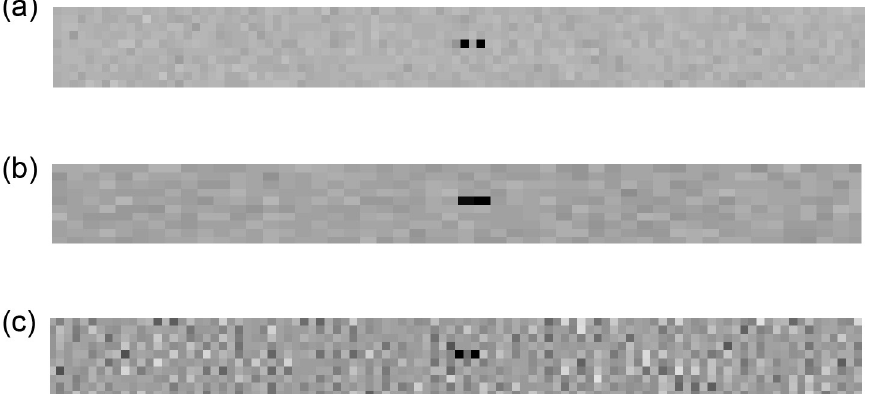
Fig 5. Projection line integral images of the Titanium blade with 1 mm 3 air pocket defects imaged using (a) 1 mm detector elements, (b) 2 mm detector elements, and (c) 2 mm detector elements using SPE. The defect is only correctly shown as two distinct air pockets in the 1 mm and 1 mm SP derived images. Images are unitless arguments to an exponential function (i.e., projection line integrals) and are displayed at a window setting of [0.4 0.5].